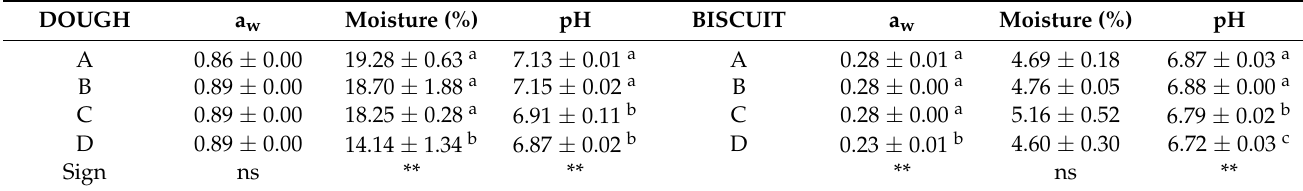
Table 3. a w , moisture, and pH values of dough and biscuit samples.